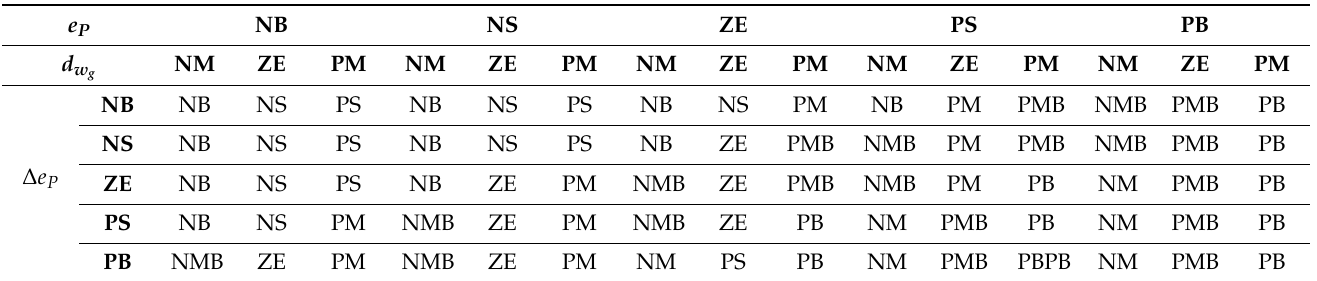
Table 1. Fuzzy Logic Control